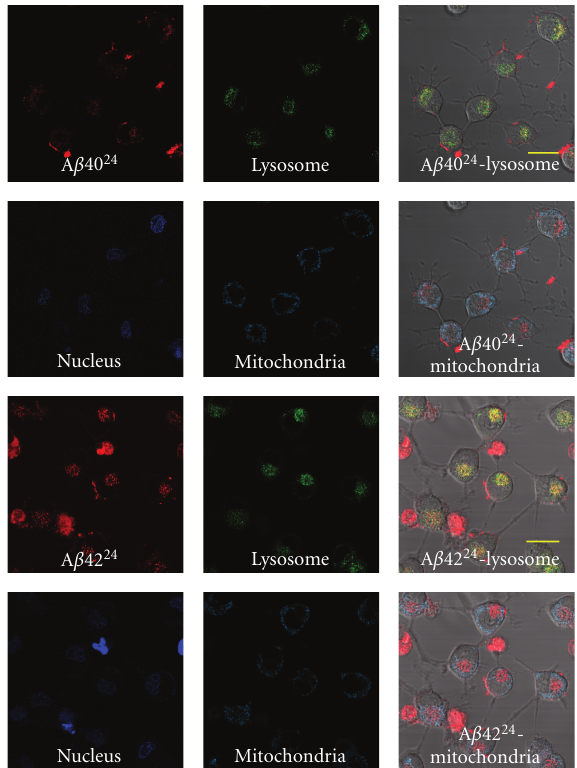
Figure 8: Intracellular localizationof endocytic A β . Confocal microscopy images through a single plane of cells treated with either A β 40 24 or A β 42 24 and intracellular markers. All scale bars are 20 μ m in length. Colocalization between the red A β 40 / 42 24 signal and the green lysosome signal is shown in yellow in the merged image. Colocalization was not observed with either mitochondrial or nuclear stains.